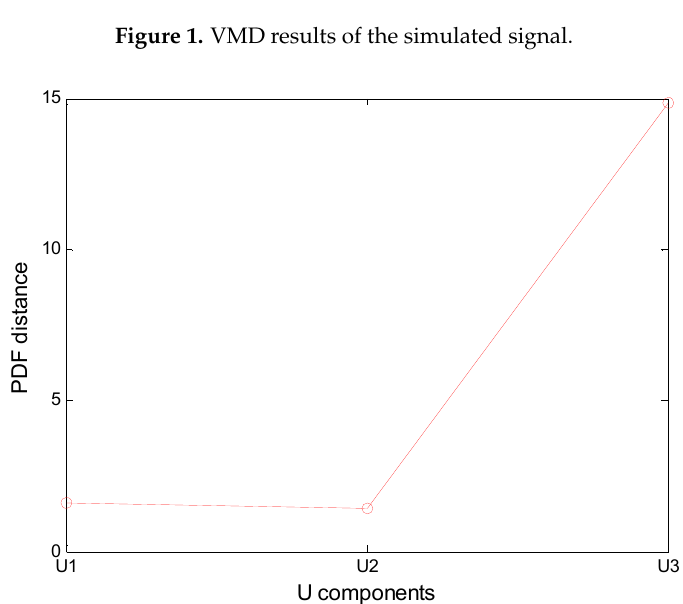
Figure 2. PDF distance between U components and the original signal.